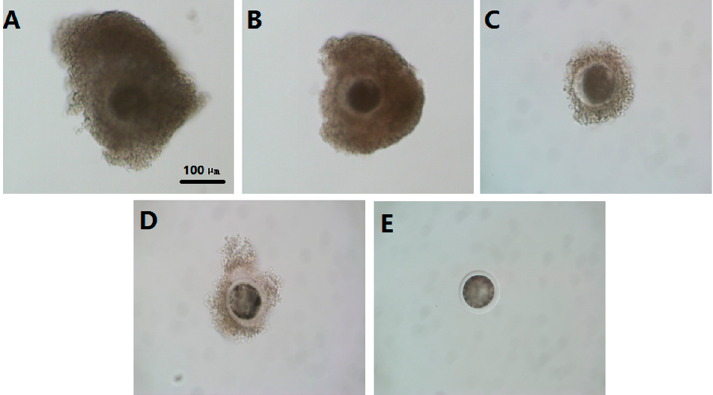
Figure 9. Classification criteria of GV oocytes. ( A ) COCs control, with an unexpanded cumulus mass having four or more layers of cumulus cells surrounding the zona pellucida and with homogenous cytoplasm; ( B ) COCs control with an unexpanded cumulus mass having three to four layers of cumulus cells and with relative homogenous cytoplasm; ( C ) oocytes with an unexpanded cumulus mass having under three layers of cumulus cells with regular cytoplasm or irregular shrunken cytoplasm; ( D ) oocytes partially denuded of cumulus cells and with irregular shrunken cytoplasm; and ( E ) oocytes completely denuded of cumulus cells and with irregular shrunken cytoplasm. C,D and E were classified as IOs. scale bar = 100 μ m.